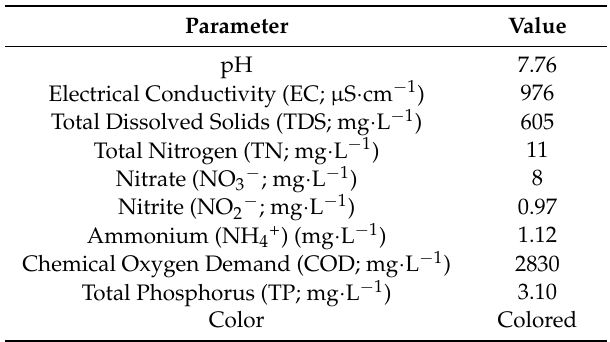
Table 1. Typical feed effluent